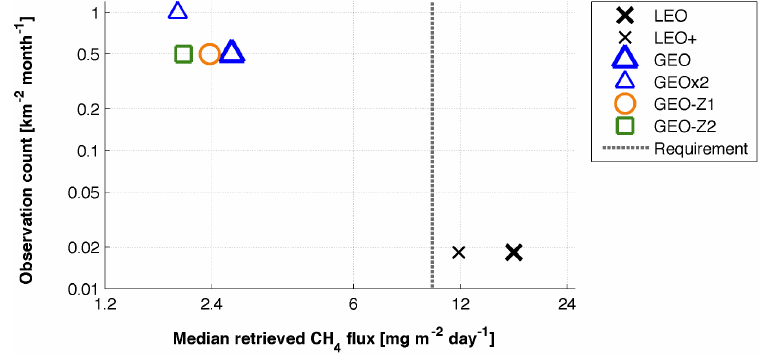
Figure 6. CH 4 observations density (observations per unit area; y axis) vs. retrievable ∼ 333km flux precision ( x axis) for six CH 4 observa- tion systems (see Table 1 for details). The “observation density” includes all attempted CH 4 measurements, including accepted (cloud-free) and rejected (cloudy)